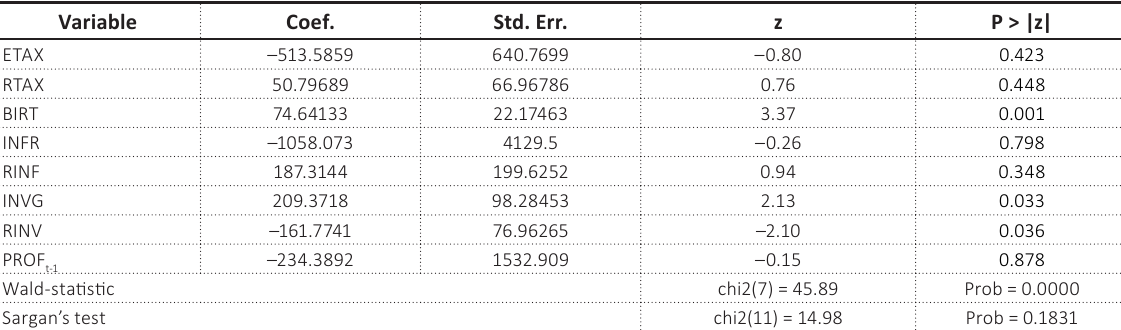
Table 7. Dynamic panel regression results of the manufacturing sector